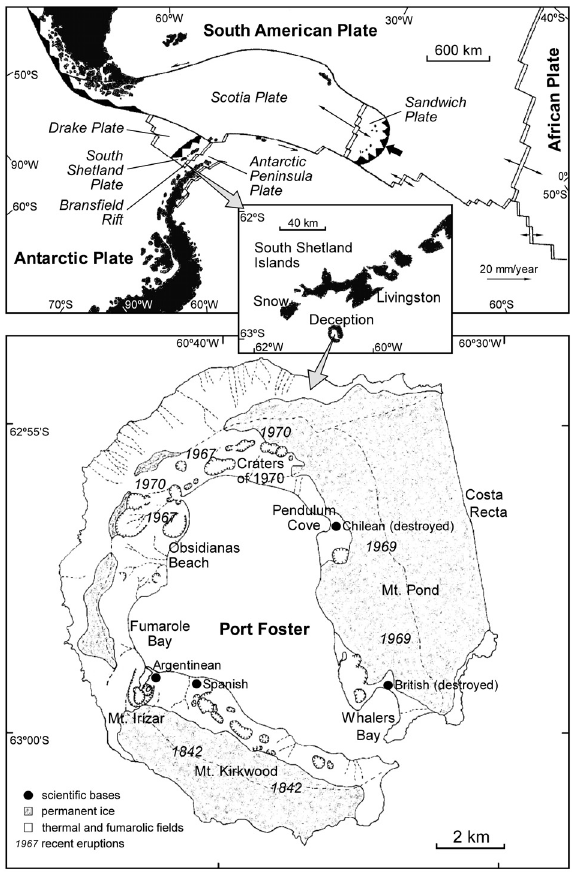
Figure 1. Simplified tectonic map showing the location of Decep- tion Island in the South Shetland Island region and map of Deception Island with indication of the main volcanic